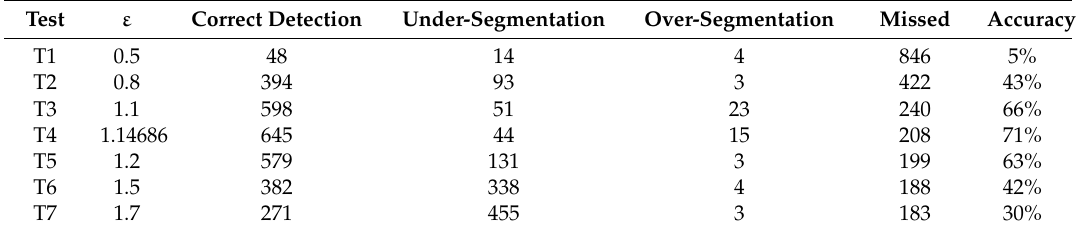
Table 6. Accuracy evaluation using different ε values of mobile laser scanning data using X , Y , Z